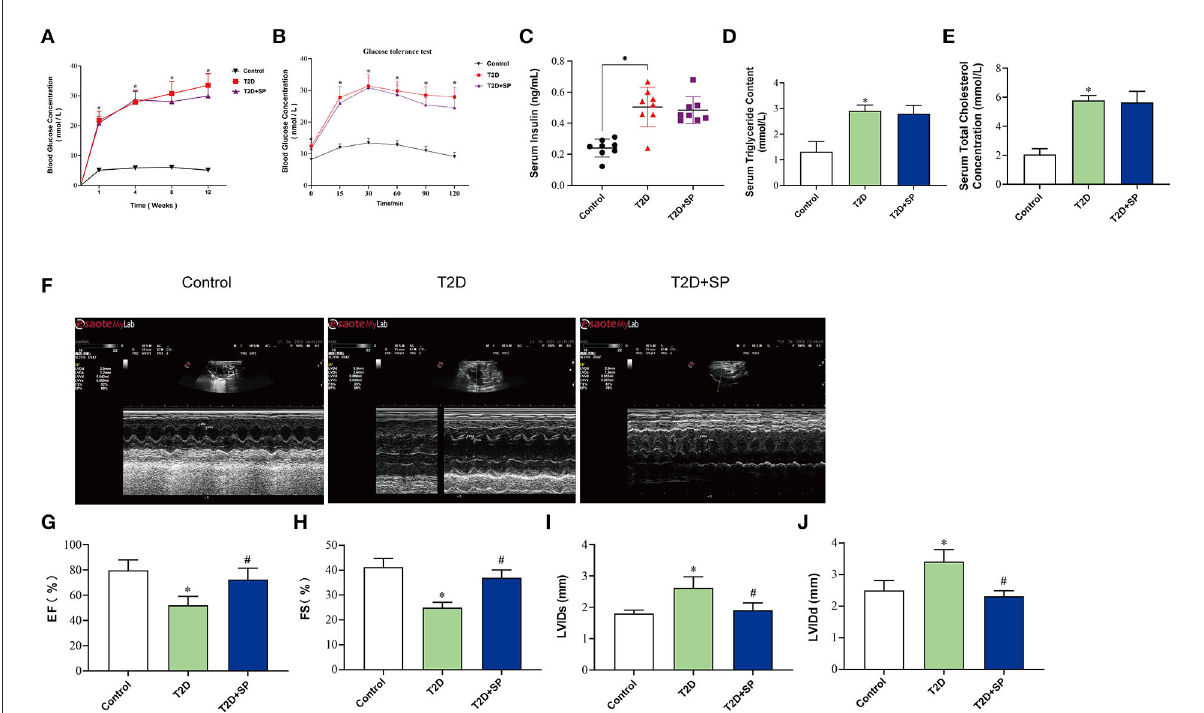
FIGURE1 SP improves cardiac functions in the T2D mouse model. Db/db mouse was selected as the research object of the T2D model, and the related indexes were determined at week 12. (A) Blood glucose concentration, (B) insulin resistance test, (C) serum insulin concentration, (D) triacylglycerol, (E) total cholesterol, (F) echocardiography, (G) left ventricular ejection fraction, (H) left ventricular fractional shortening, (I) left ventricular internal dimension systole, and (J) left ventricular internal dimension diastole * P < 0.05 vs. Control group; # P < 0.05 vs . T2D group ( n = 8).